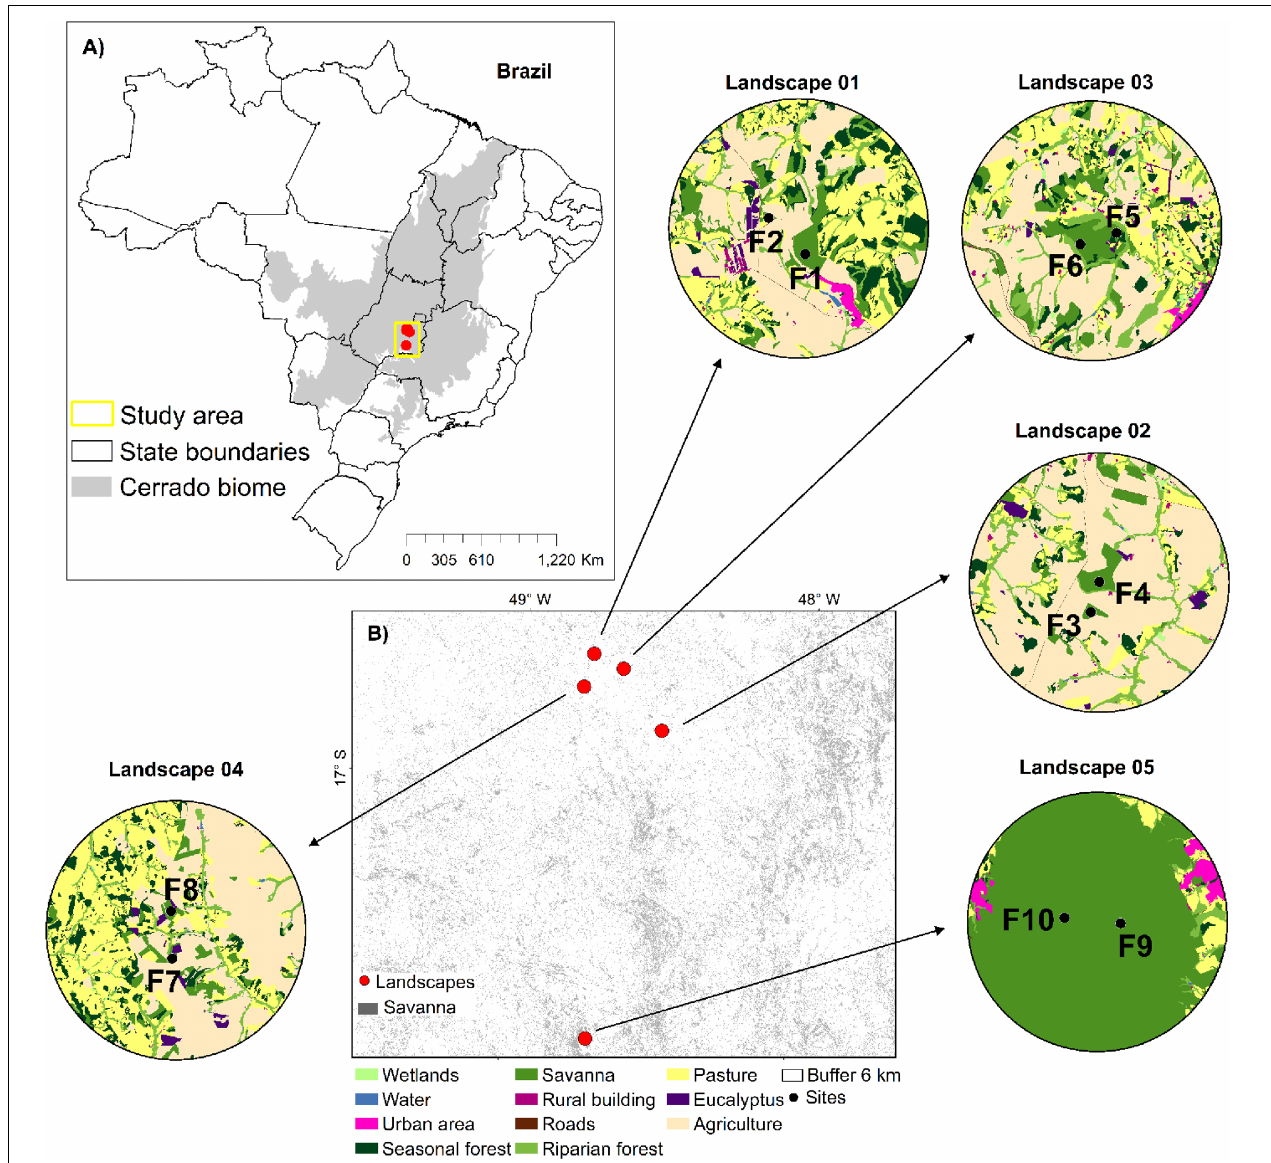
FIGURE 1 | Geographic distribution of the five landscapes and the 10 sampling sites of Tabebuia aurea in the Brazilian Cerrado. (A) The distribution of the Cerrado biome in Brazil and the landscapes sampled. (B) The landscapes represented by a buffer of 6 km and the sampling sites (black dots). Land use categories are in legends. For details of sampling sites see Appendix Table S1